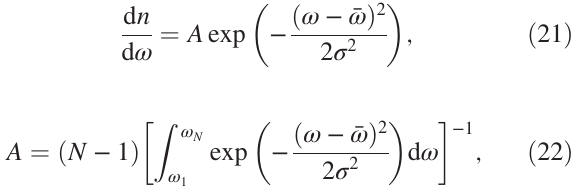
FIG. 18. The gradient profile of a structure with Gaussian tapered irises. The gradient is given for a range of σ where the Δ ω = 2 π ¼ 1 . 5 GHz, L ¼ 0 . 5 m and h G i ¼ 80 MV = m for this example.